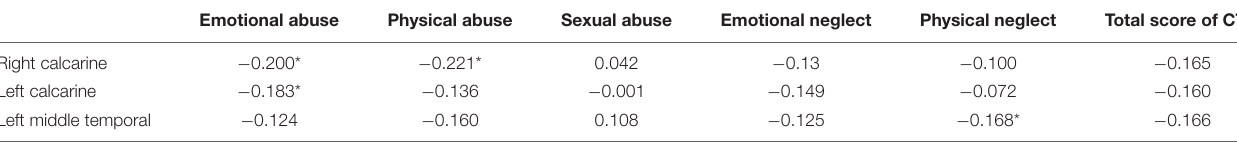
TABLE 7 | Correlation between voxel wise concordance and childhood trauma.